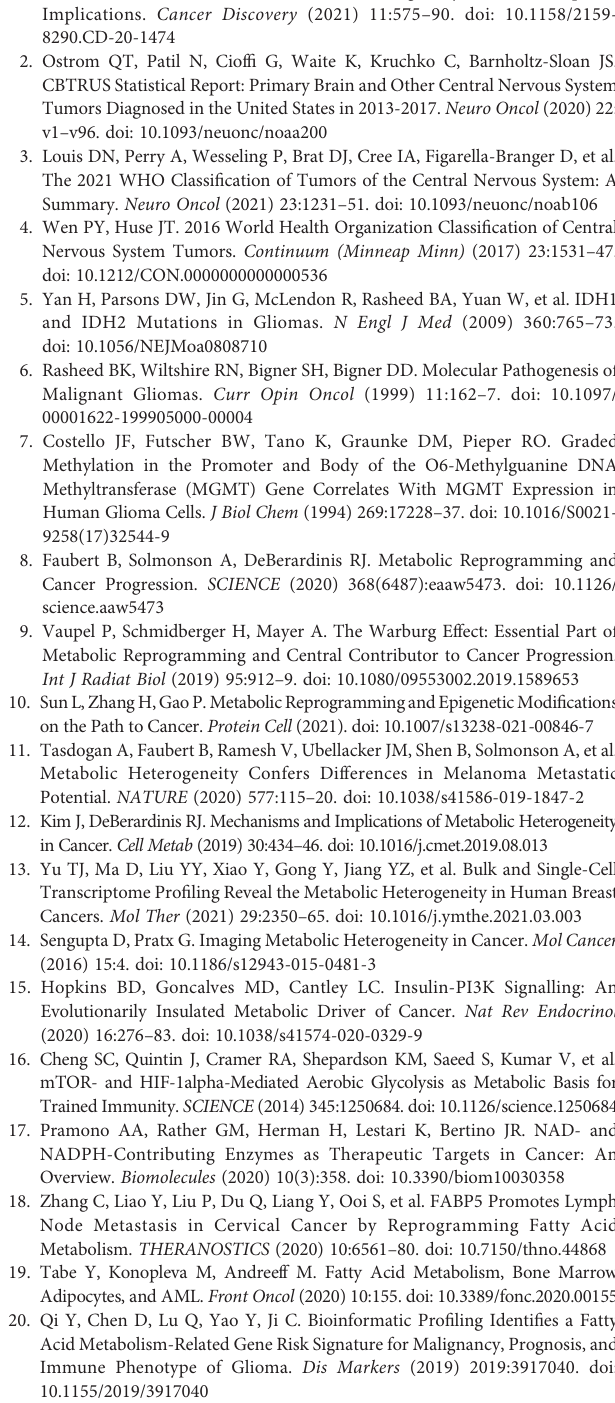
Supplementary Table 1 | The gene collections were gathered for the prior study ’ s assessment of immune-related aspects in TME. Supplementary Table 2 | PPI network data.